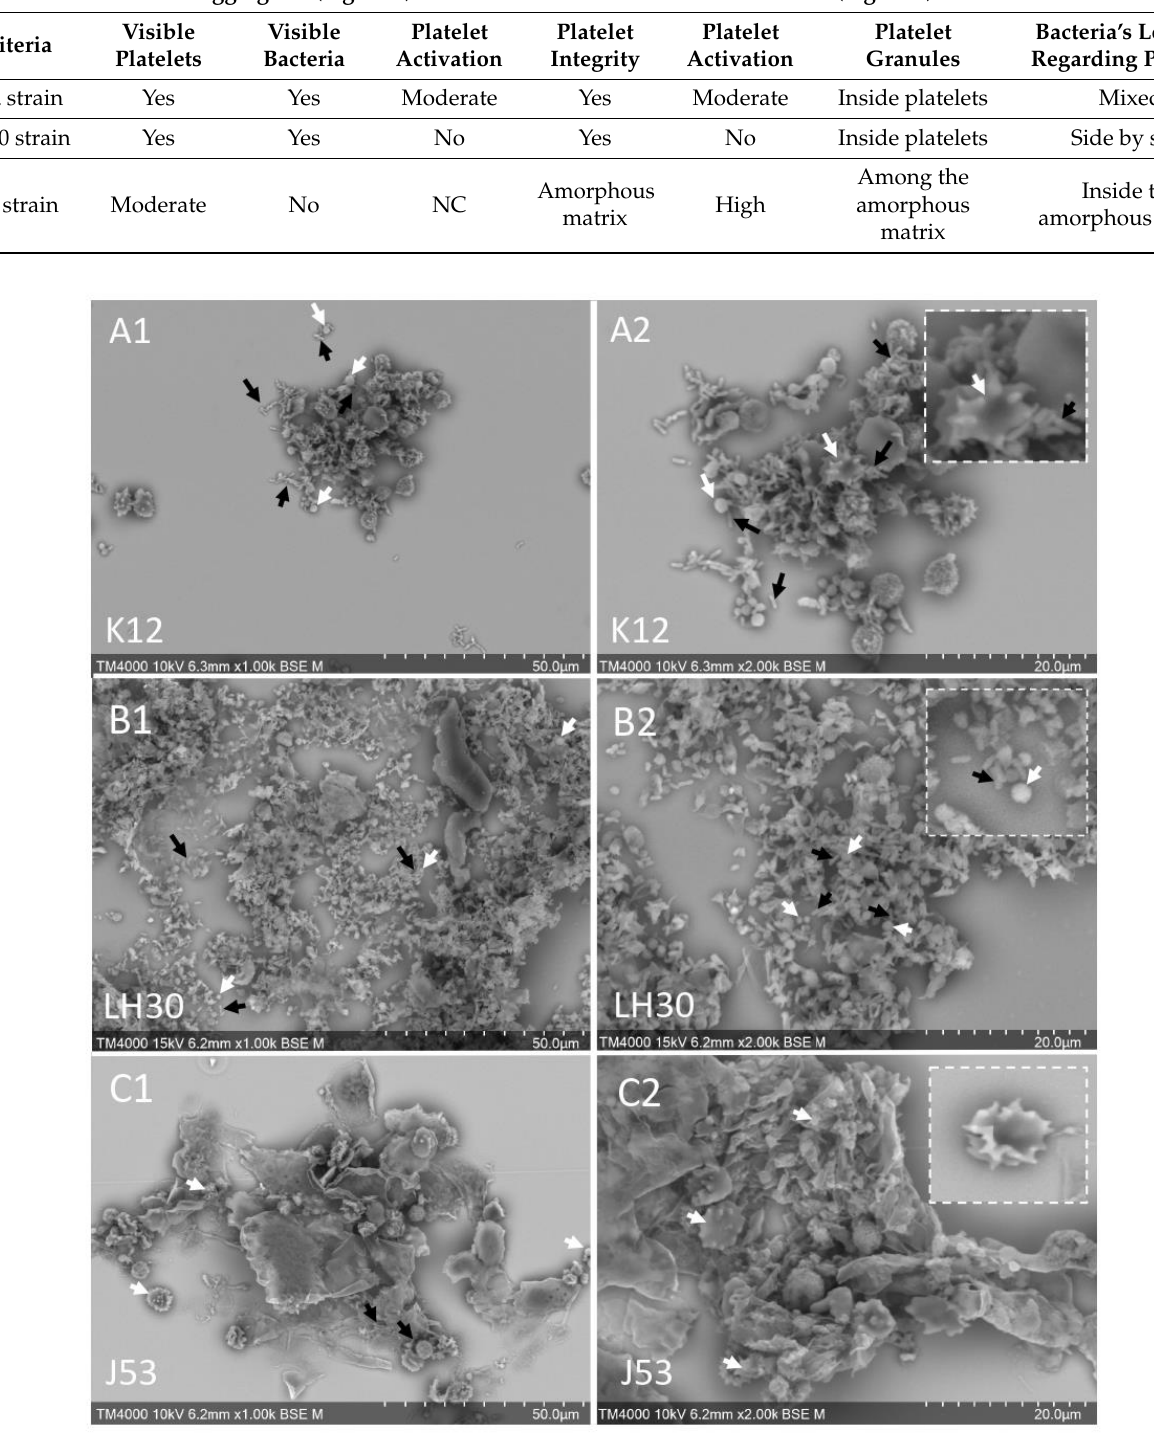
Figure 1. BSE-SEM observation of whole platelets- E. coli mixtures. ( A1 , A2 ): Platelets and E. coli K12 mixture; ( B1 , B2 ): Platelets and E. coli LH30 mixture; ( C1 , C2 ): Platelets and E. coli J53 mixture. White arrows: platelets, black arrows: bacteria.